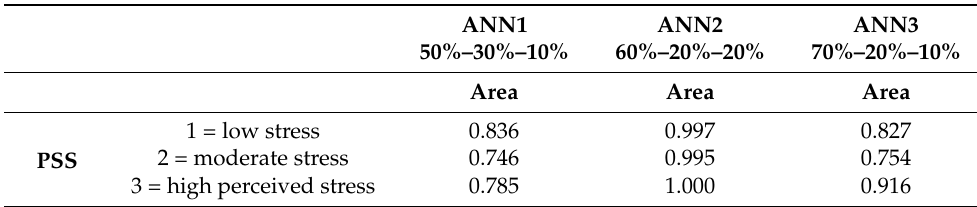
Figure 2. ANN2 model’s predicted pseudo-probability presented by a box-plot diagram for the three PSS variable categories. With further processing, the ANN2 model was validated by the ROC curve, which showed the classification performance for all possible cutoffs by a diagram of sensitivity versus specificity. The measures of sensitivity and specificity for the designed ANN1, ANN2, and ANN3 models were presented as an area under the curve (AUC), which presents the entire position of the ROC curve according to the PSS variable’s three stress categories: low stress, moderate stress, and high perceived stress (see Table 7). Table 7. Area under the